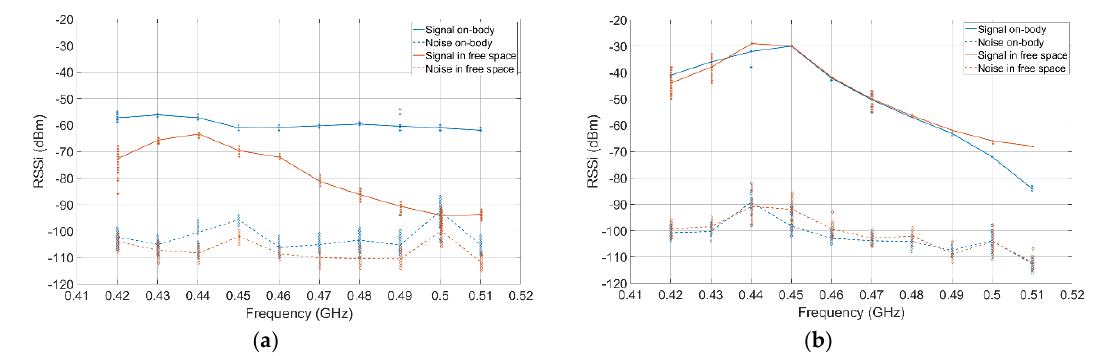
Figure 11. Attenuation over frequency with electrodes ( a ) and monopole ( b ) in free space (air) versus on-body for a 20 cm range. Dashed lines represent the noise floor. The solid curves show the average values at each frequency while the markers show the individual measured samples.